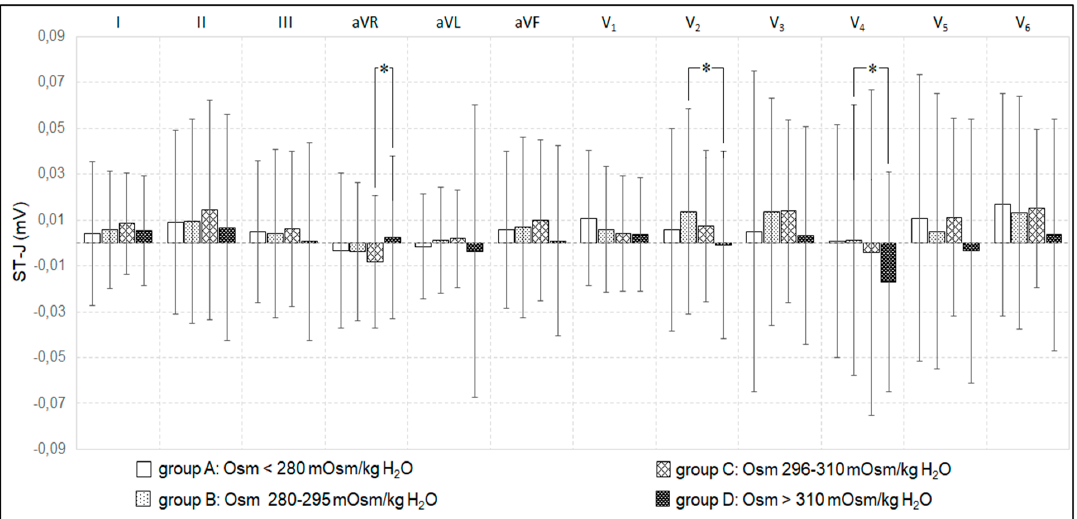
Figure 4. Changes in STJ segments in 12 leads in relation to plasma osmolality. * p < 0.05 –significant differences between studied groups.